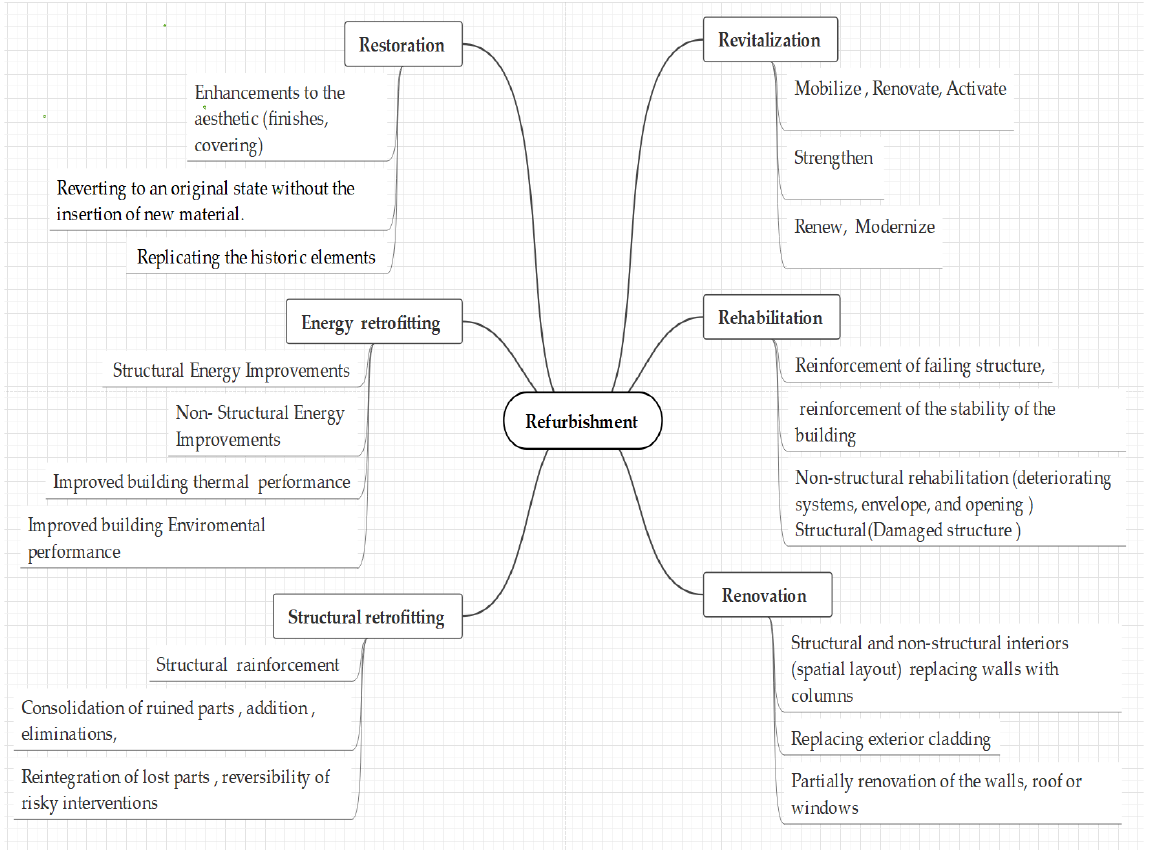
Figure 2. Building physical adaptation terminologies related to refurbishment.